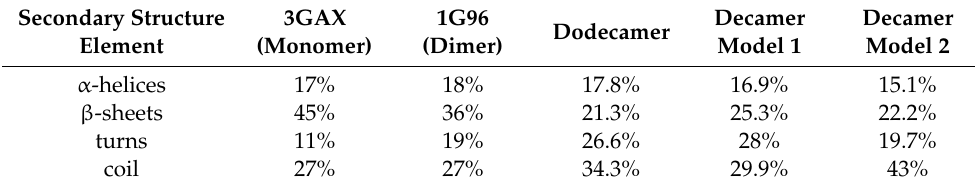
Table 2. Secondary structure content of the proposed stab-1 HCC oligomer structures calculated using the STRIDE web server [44] and compared with values derived from the crystal structure of the stab-1 HCC monomer (PDB code: 3GAX; [14]) and the HCC dimer (PDB code: 1G96; [12]).